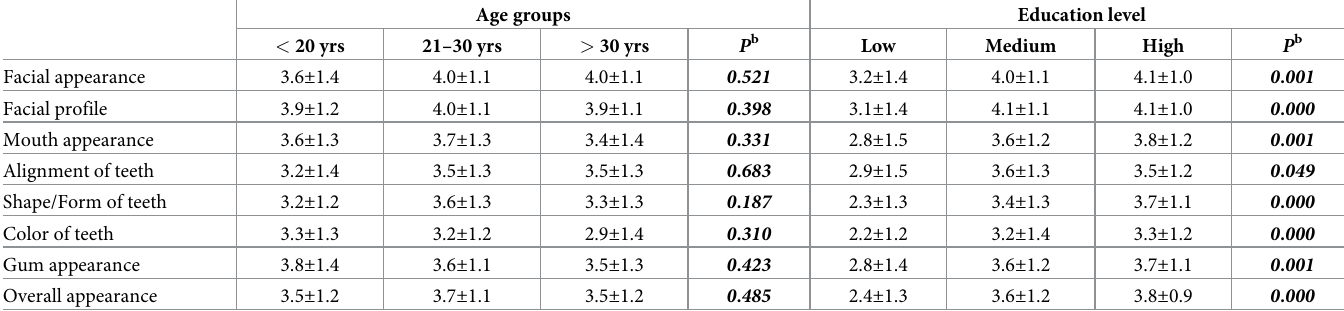
Table 4. Responses to OES-Ar questionnaire according to age and education level.